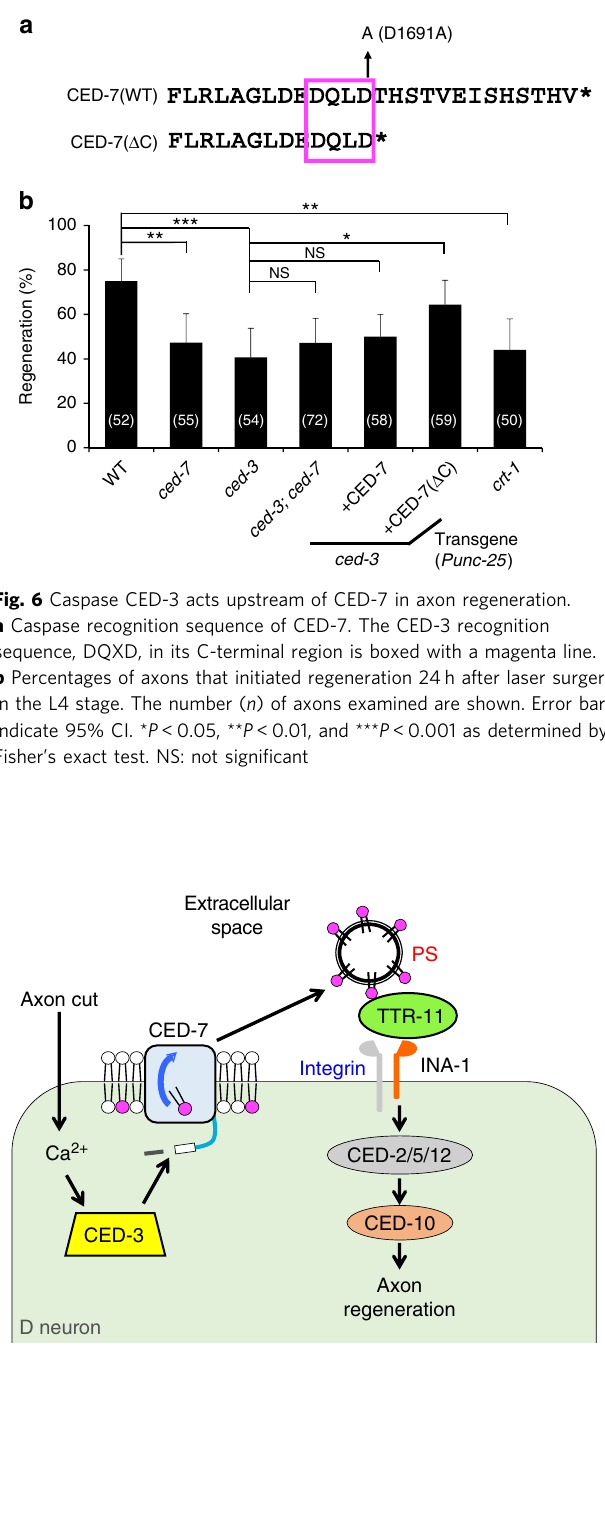
Fig. 7 Schematic model for the regulation of axon regeneration by caspase- dependent PS exposure. Axonal injury triggers a rise in intracellular calcium, resulting in the activation of CED-3. This, in turn, activates CED-7, leading to an increase in PS exposure. TTR-11 could act as an extracellular PS acceptor and PS-associated TTR-11 may in turn activate integrin. This signal is relayed intracellularly through the CED-2 – CED-5 – CED-12 module